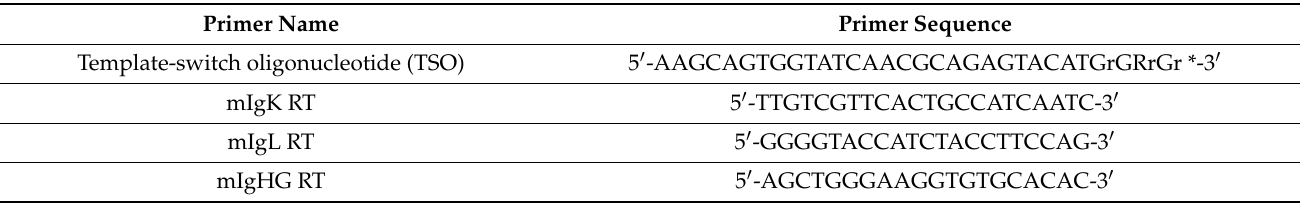
Table 1. The primers and the general template-switch oligonucleotide (TSO) used in the primer-specific reverse transcription of mRNA.